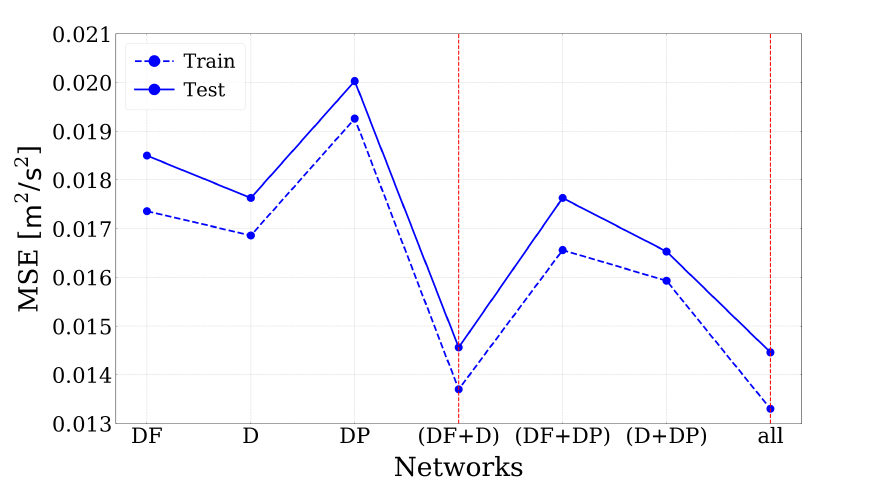
Figure 6. Visualization of the training and testing MSE values (using UX, N = 20, 24, 30 samples) according to different input variables for networks with two hidden layers, including three and two hidden perceptrons, respectively. The red dashed line corresponds to the networks with the lowest values of